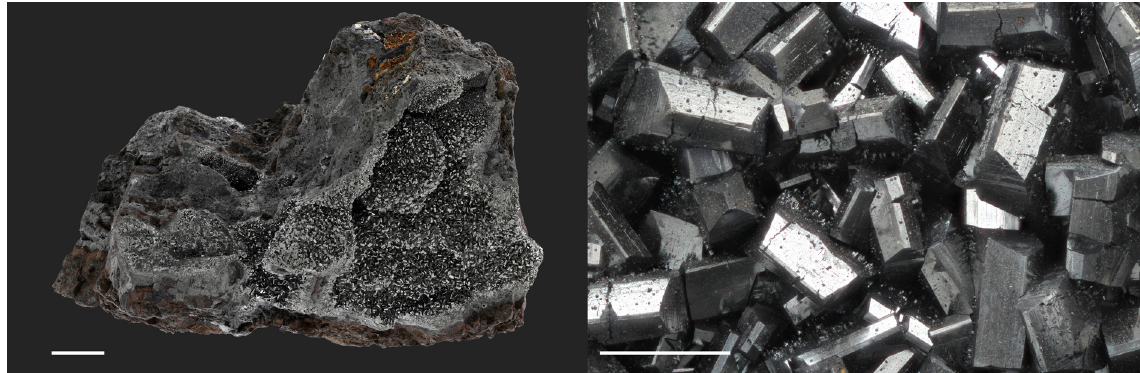
Fig. 2.3. Picturing shiny metallic specimens: Left: A manganite specimen (scale = 1 cm); Right: a detailed view of the manganite specimen (scale = 1